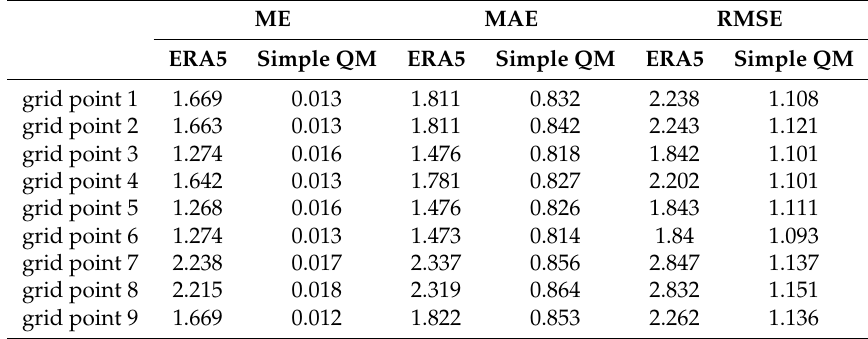
Table 4. Error metrics of ERA5 grid points’ wind speeds and their calibrated counterparts against the measurements, expressed in m/s.